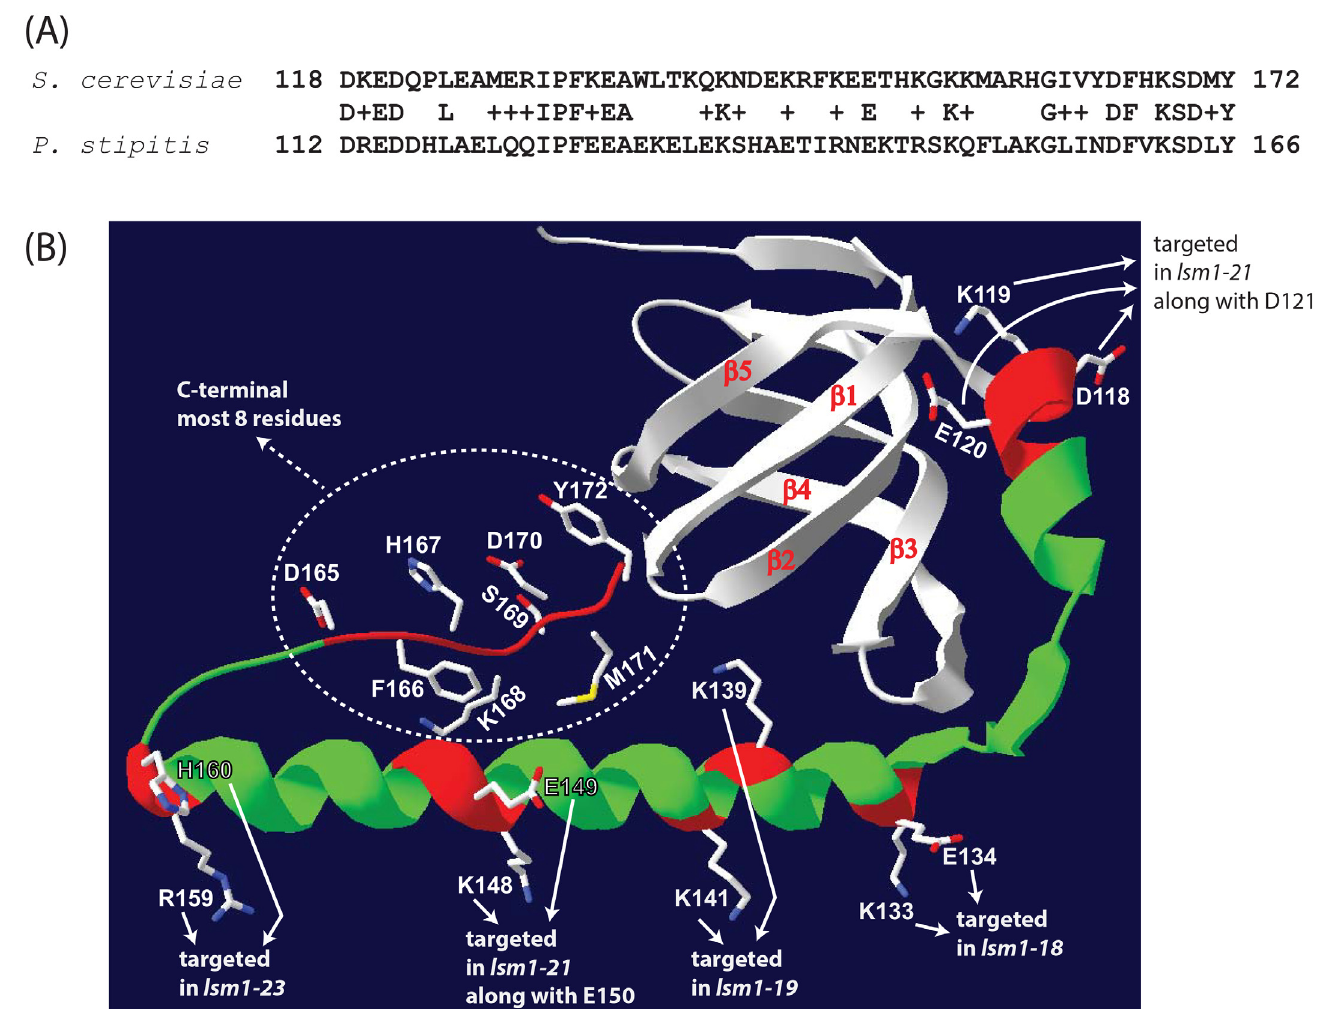
Fig 1. A , Alignment of the C-terminal most 55 residues of S . cerevisiae and P . stipitis Lsm1 proteins. Numbers of the first and last residues are indicated on the left and right of the sequence. B , Three dimensional structure of Lsm1 subunit in the Lsm1-7 complex (PDB ID: 4C92; Sharif and Conti, 2013) is shown as ribbon diagram. Parts of the ribbon corresponding to some of the C-terminal extension residues targeted in the lsm1 mutants are shown in red. For these residues the orientation of the side chains is also shown. Rest of the C-terminal extension is shown in green. The N- terminal extension and the Sm domain are shown in